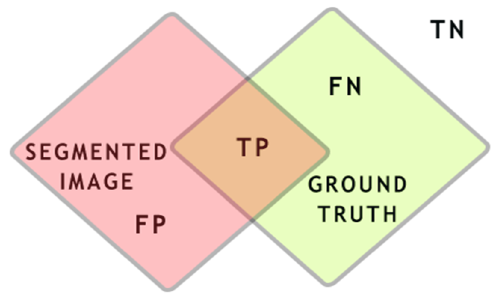
Figure 4. TN represent the pixels that have not been segmented, FN represent the pixels that should appear in the segmented image, TP are the joint segmented pixels, and FP represents the pixels that should not have been